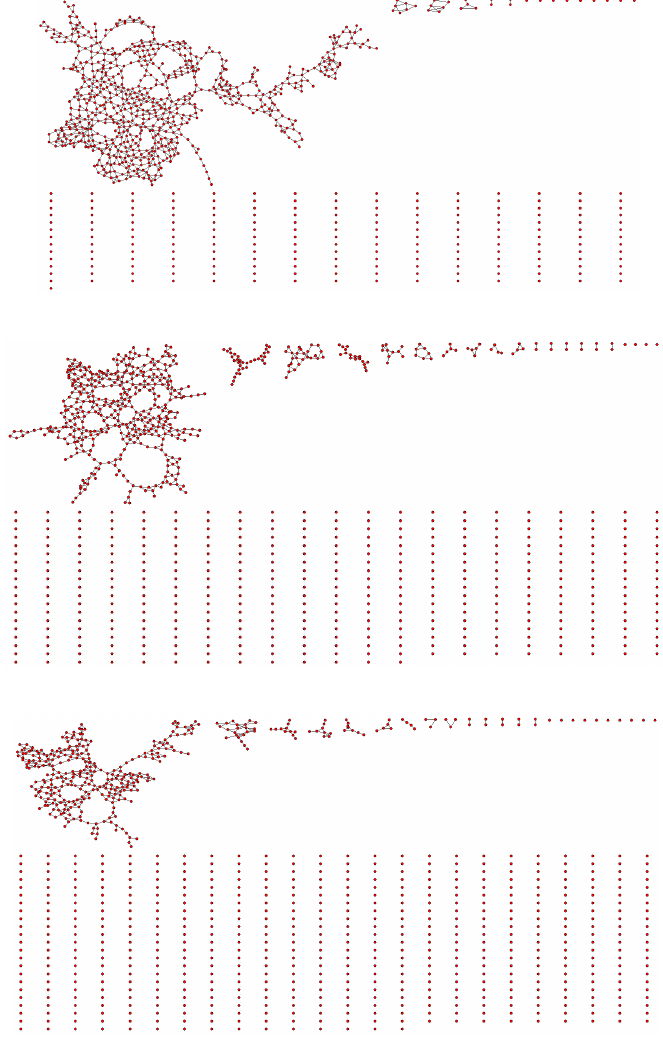
Figure 6. Traffic network structure of the study area under different inundation scenarios. (Source: self-drawn by the author). Table 2. Section pair number, weight, and schematic diagram of the flood-damaged sections. Number of Section Pair